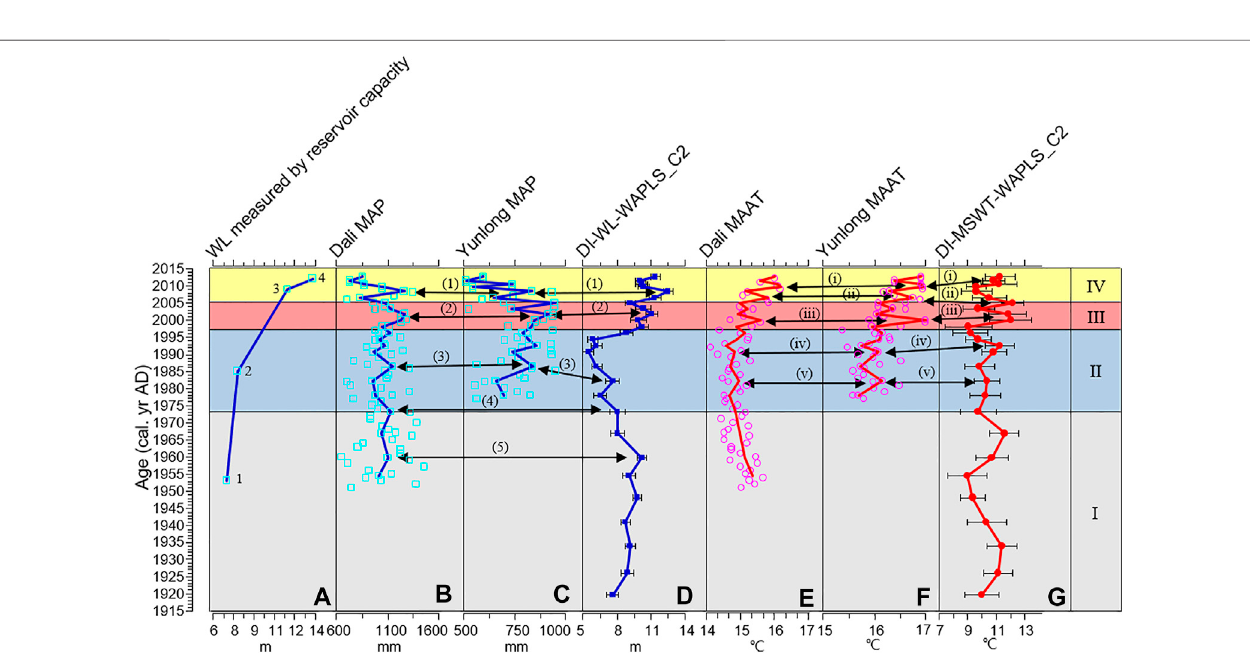
FIGURE 7 | Comparison of diatom-inferred lake water level, mean surface water temperature and meteorological and reservoir capacity records over the last ∼ 100 years inthe Yunlong Lake area. (A) Long-term changein lakewater level estimatedbythe reservoir capacityrecords and the measuredwater level in2013. (B) Mean annualprecipitation (MAP) during 1950 – 2013recordedbyDaliStation. The squares represent the measured datapoints, and the solid line representsthe fi ttedtrend ofthe precipitation corresponding to the diatom sampling points based on sediment dating, and the same below. (C) Mean annual precipitation (MAP) during 1977 – 2013 recorded at Yunlong Station. (D) Diatom-inferred lake water level obtained using WAPLS-Component 2 and the estimated reconstruction errors. (E) Mean annual air temperature (MAAT) during 1950 – 2013 recorded at Dali Station. The circles represent the measured data points, and the solid line represents the fi tted trend of the air temperature corresponding to the diatom sampling points based on sediment dating, and the same below. (F) Mean annual air temperature (MAAT) during 1977 – 2013 recorded at Yunlong Station. (G) Diatom-inferred MSWT obtained using WAPLS-Component 2 and the estimated reconstruction errors. 1 – 4 representsfour damming and reservoir extension time interval. (1) – (5) represents fi ve interannual interval of increased precipitation. (i) – (v) represents fi ve interannual interval of increased temperature.